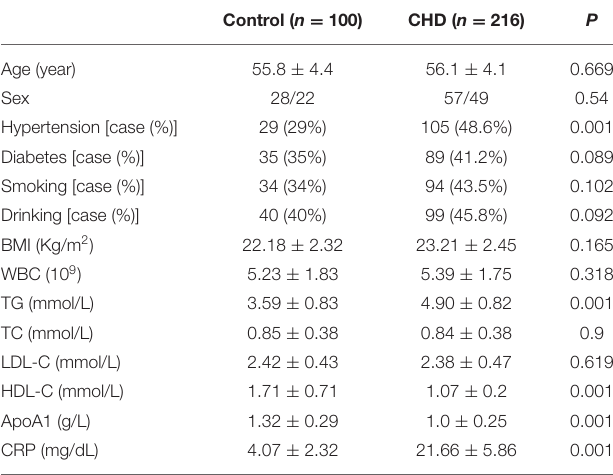
TABLE 1 | Comparison of clinical